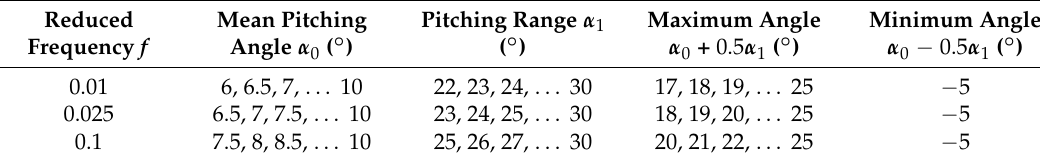
Table 1. Pitching angles and reduced frequencies investigated.